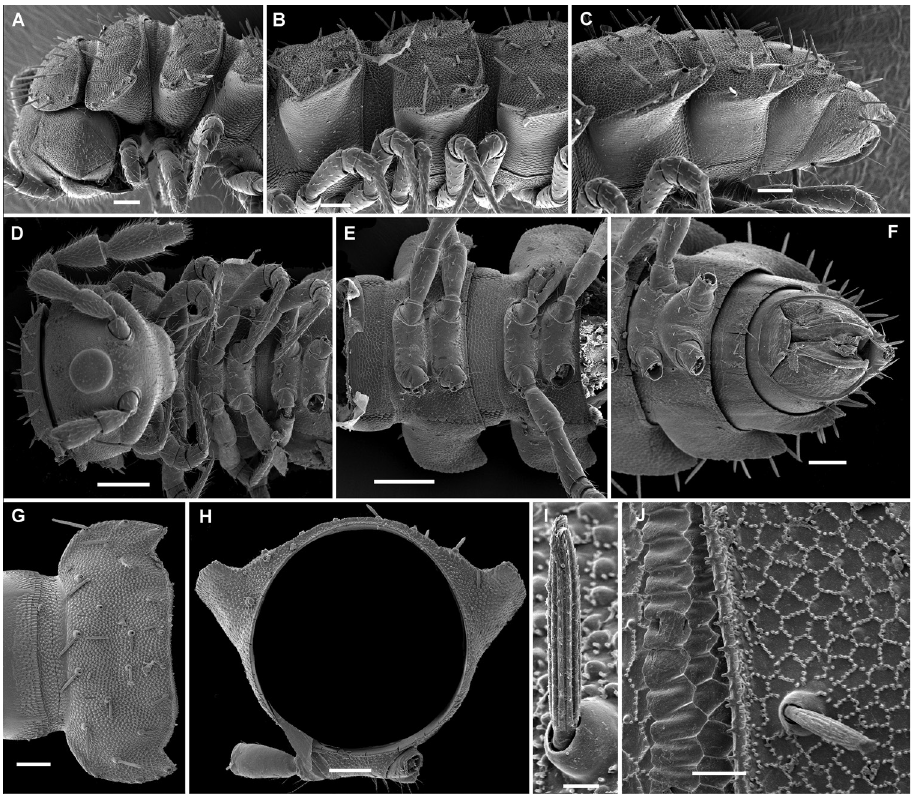
Figure 17. Hemisphaeroparia bonakanda sp. n., SEM micrographs of ♂ paratype A, D anterior part of body, lateral and dorsal views, respectively B, E midbody segments, lateral and dorsal views, respectively C, F posterior part of body, lateral and dorsal views, respectively G, H midbody segment, dorsal and caudal view, respectively I tergal seta, lateral view J tergal fine structure, dorsal view. Scale bars: 0.2 mm ( D, E ), 0.1 mm ( A–C, F–H ), 0.02 mm ( J ), 0.01 mm ( I